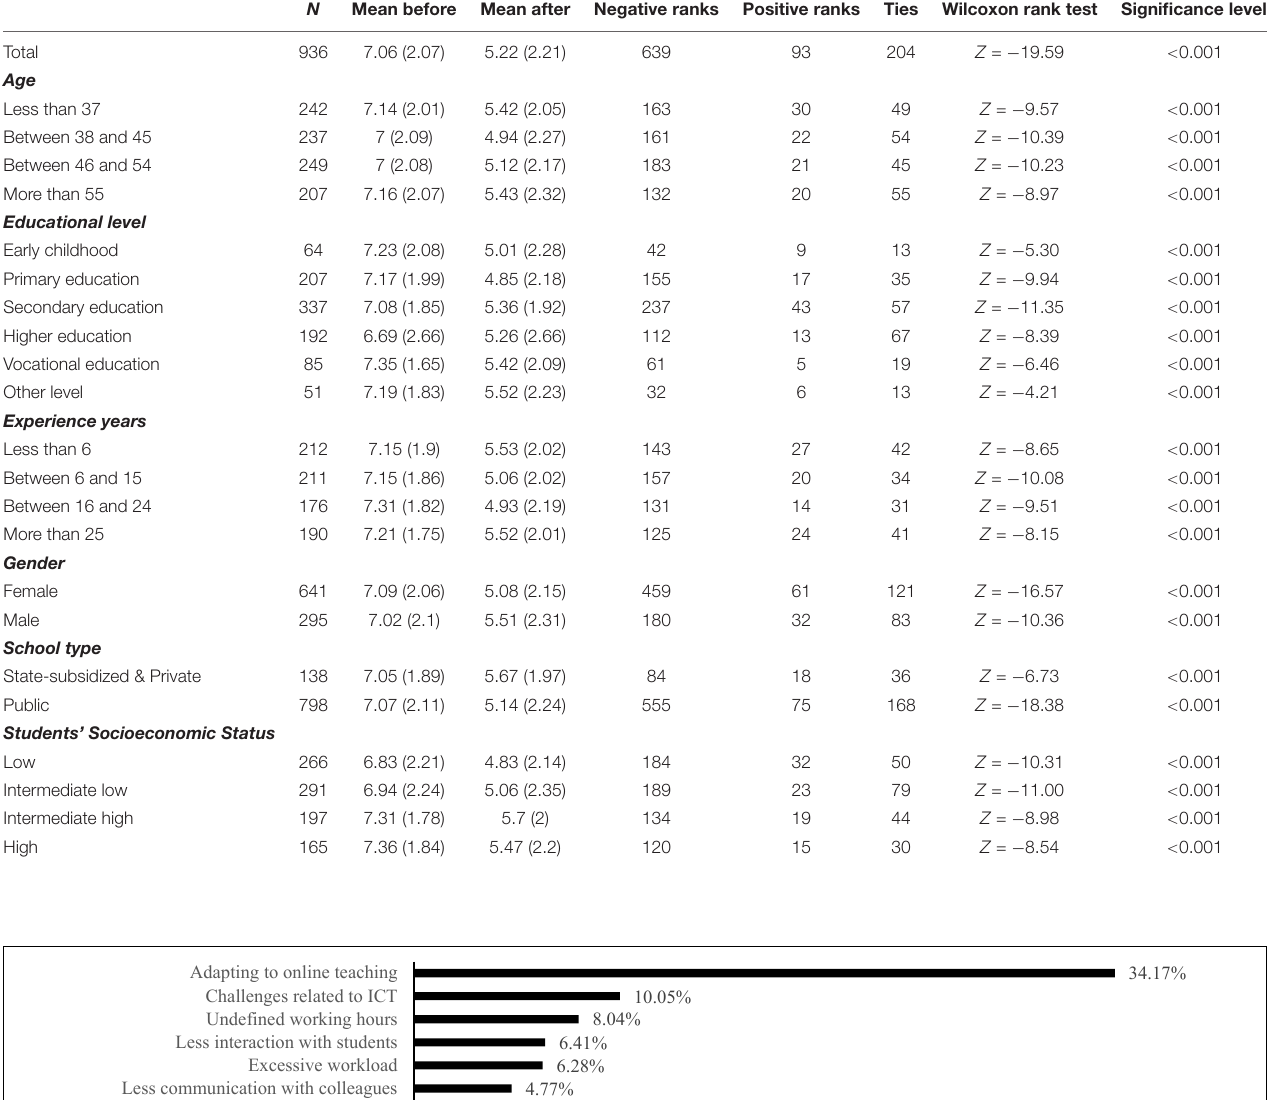
TABLE 3 | Teachers’ well-being before and after emergency remote teaching.